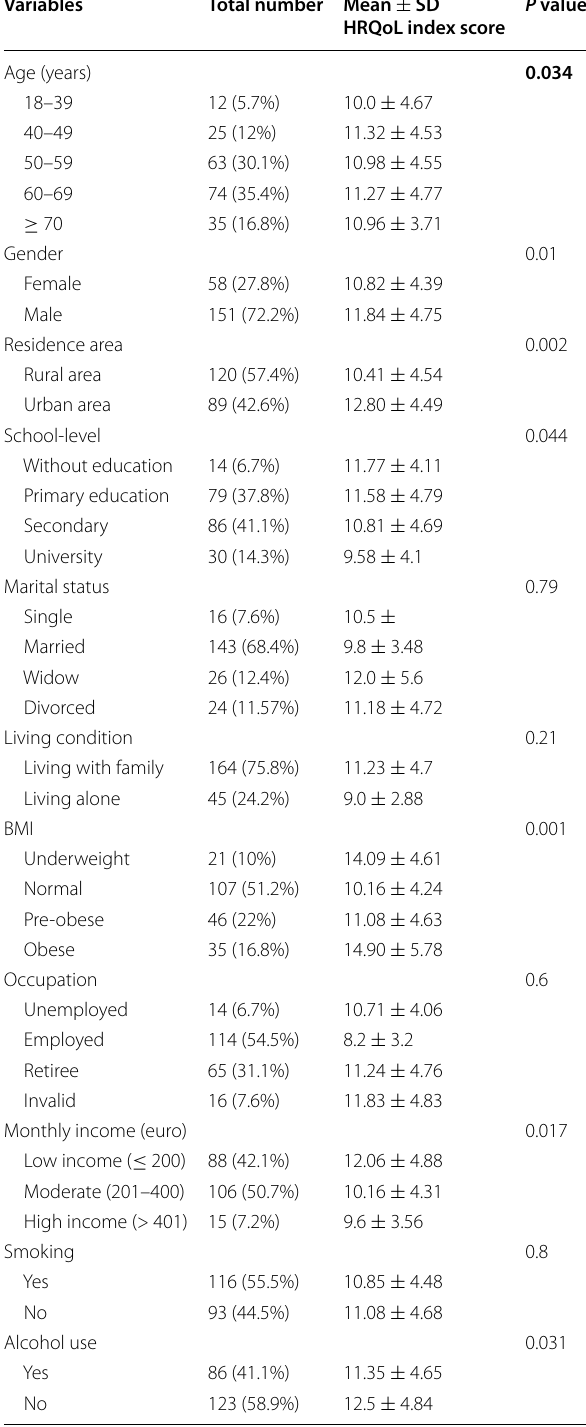
Table 1 The distribution of epidemiological data and the risk factors for hemodialysis patients and the correlation between QoL and general